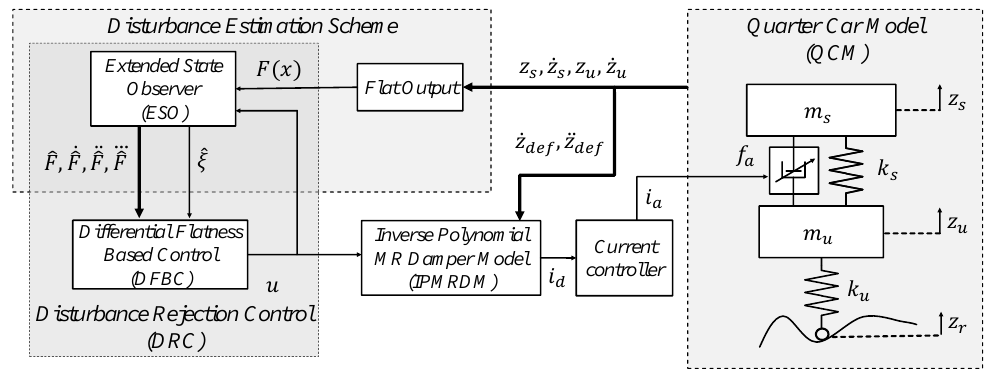
Figure 5. DRC system for semi-active suspension with